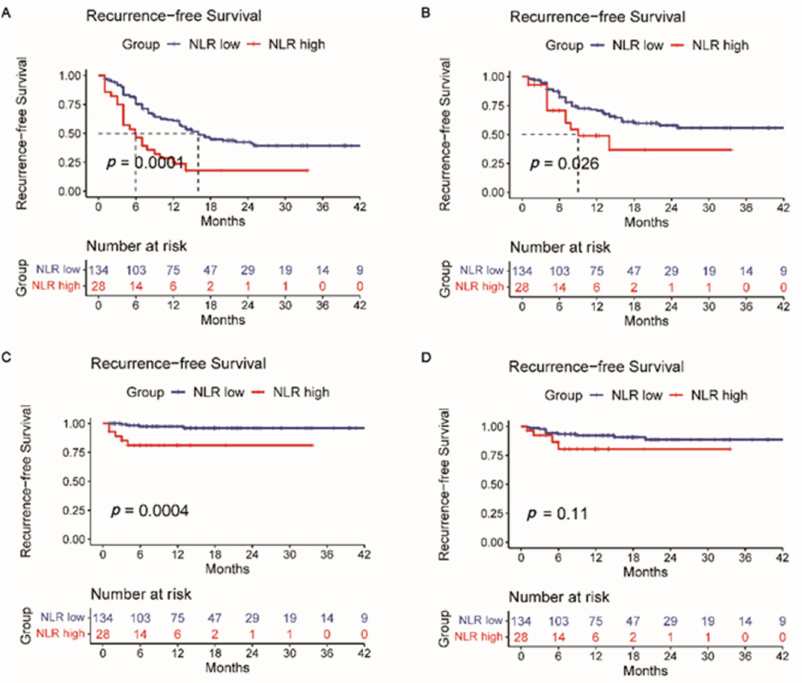
Figure 5. The value of NLR in predicting ( A ) recurrence-free survival, ( B ) intrahepatic recurrence, ( C ) lymph node metastasis, and ( D ) distant metastasis